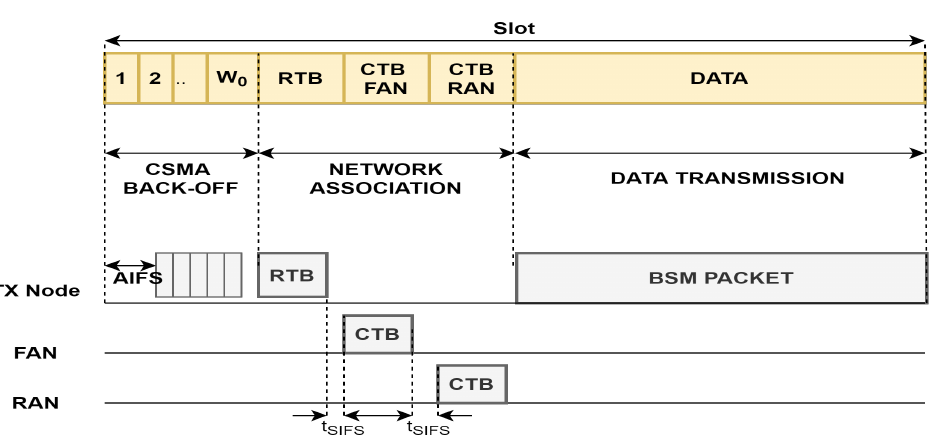
Figure 5. Frame structure of NA MAC for collision avoidance